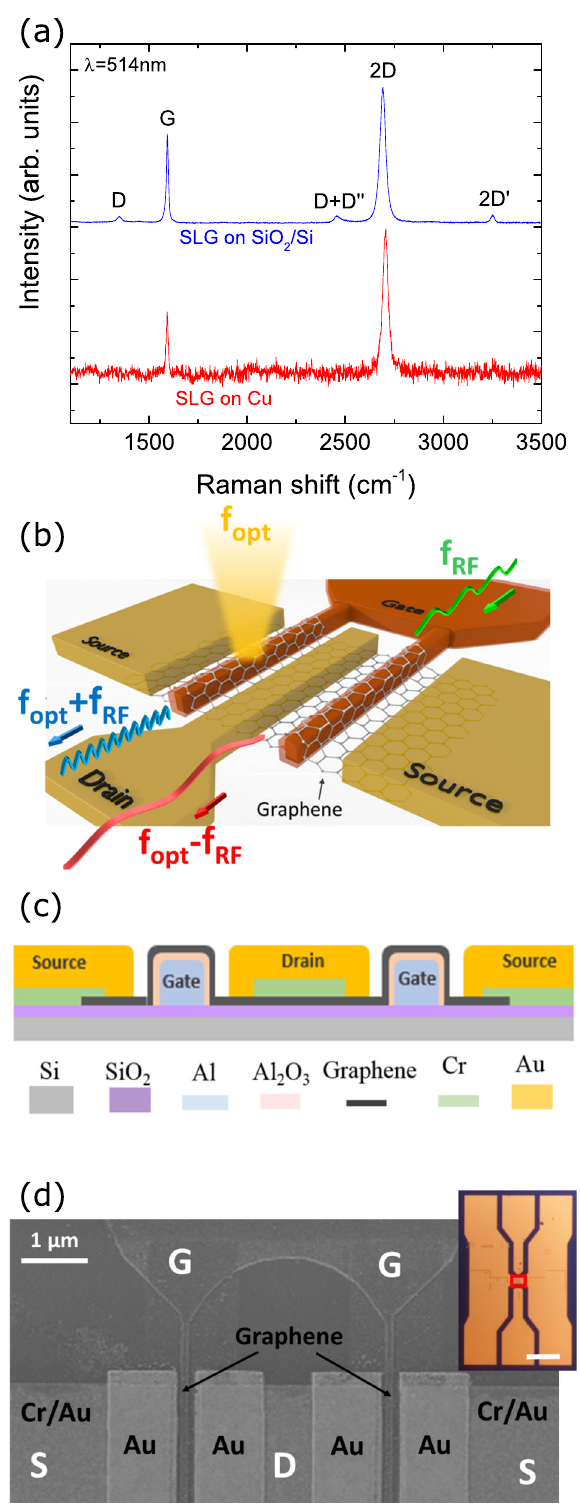
sketch of our SLG OEM and illustrates its operational principle. It consists of a GFET with a symmetric dual-bottom gate fi nger. This layout is commonly used for RF applications 51 and GFETs 52 , and is well suited for GCPWs 53 . Dual-gate fi nger FETs have a more compact design and a reduced small-signal gate resistance compared with single-gate con fi gurations, for a given equivalent